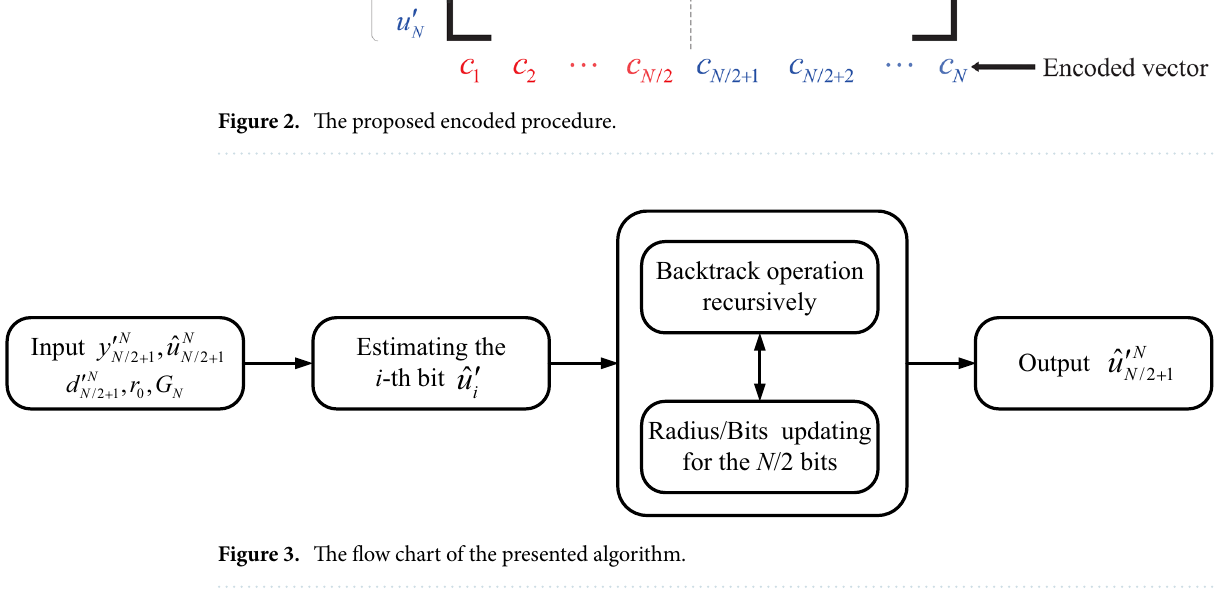
Figure 3. The flow chart of the presented